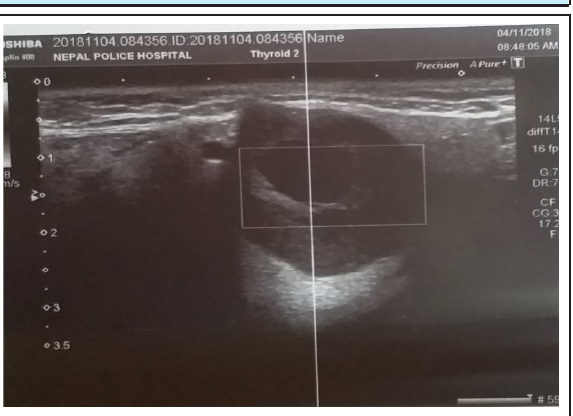
Figure 2. USG neck showing a 3.0 x 2.4 x 2.1 cm well defined Hypoechoic lesion in right submandibular gland with cystic component.